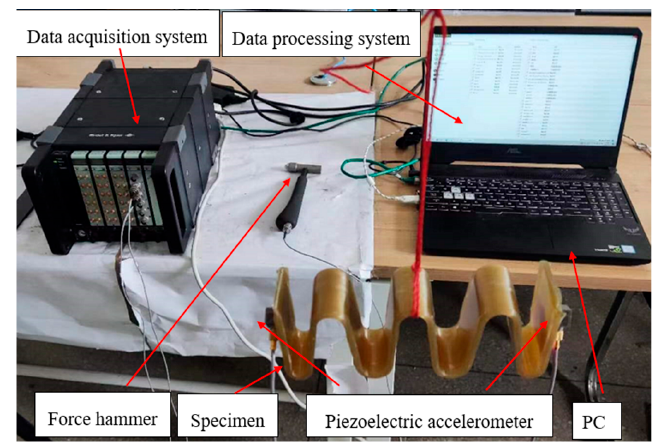
Figure 9. Hammer experiment bench installation diagram.